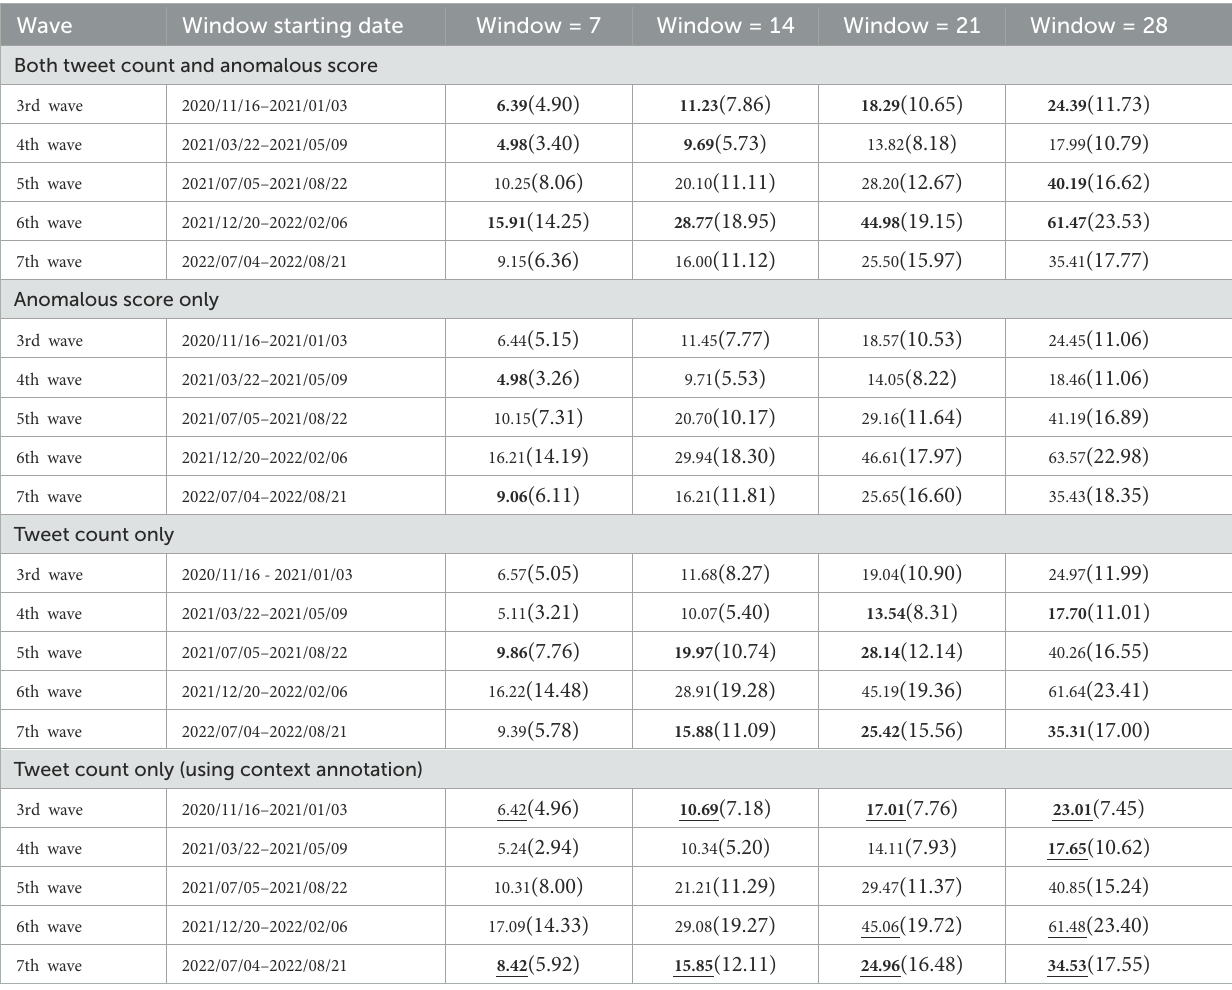
TABLE 3 COVID-19 case prediction system performance with use of tweet count and anomalous score together and alone for each wave. Wave Window starting date Window = 7 Window = 14 Window = 21 Window =